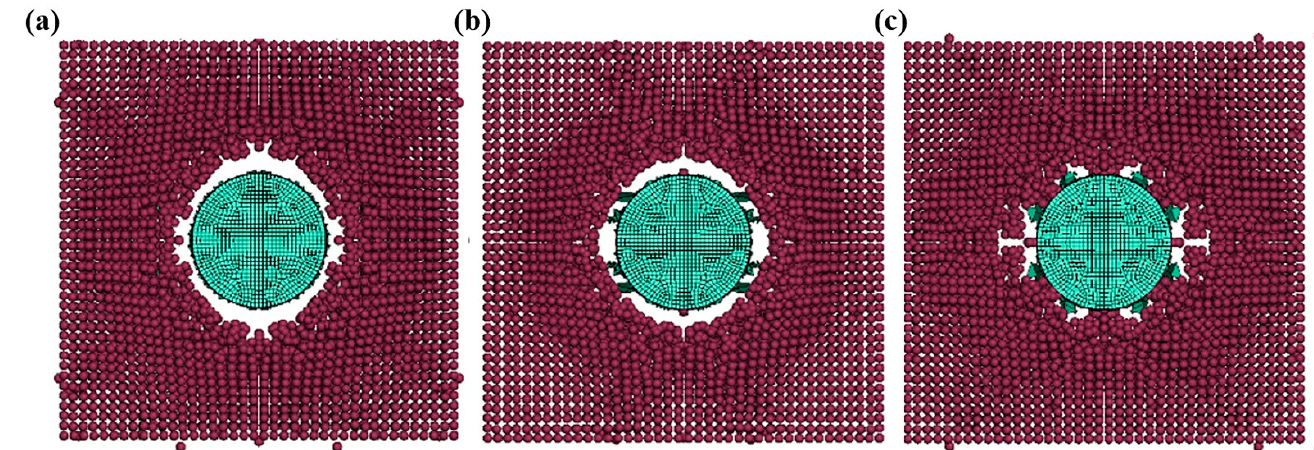
Figure 6. Front view of target hole formed after different alloy materials penetrate the target plate. ( a ) Du alloy; ( b ) tungsten alloy; ( c ) high-strength steel.